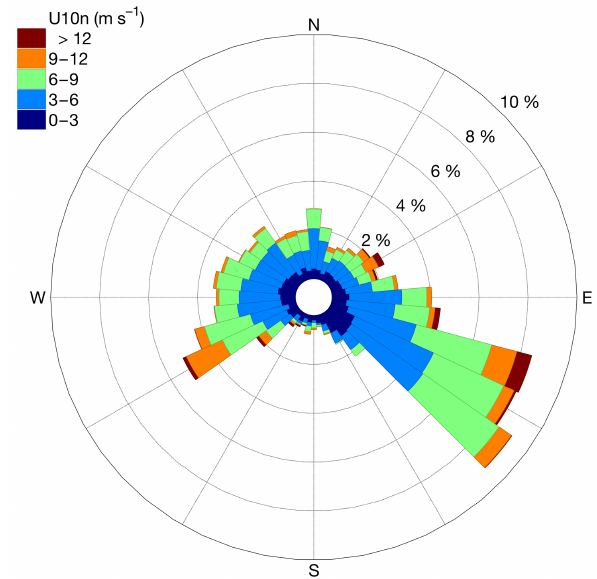
Figure 7. Wind rose for May to September 2017 shown with 10 ◦ wind direction bins. Color represents 10m neutral wind speed and the size of the bars indicates the frequency at which they